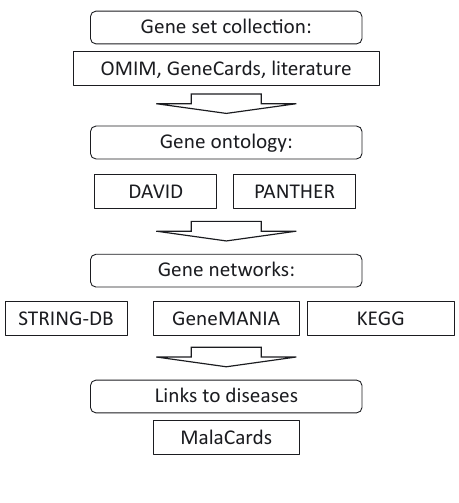
Figure 1: Workflow for information data processing for glioblastoma genes.